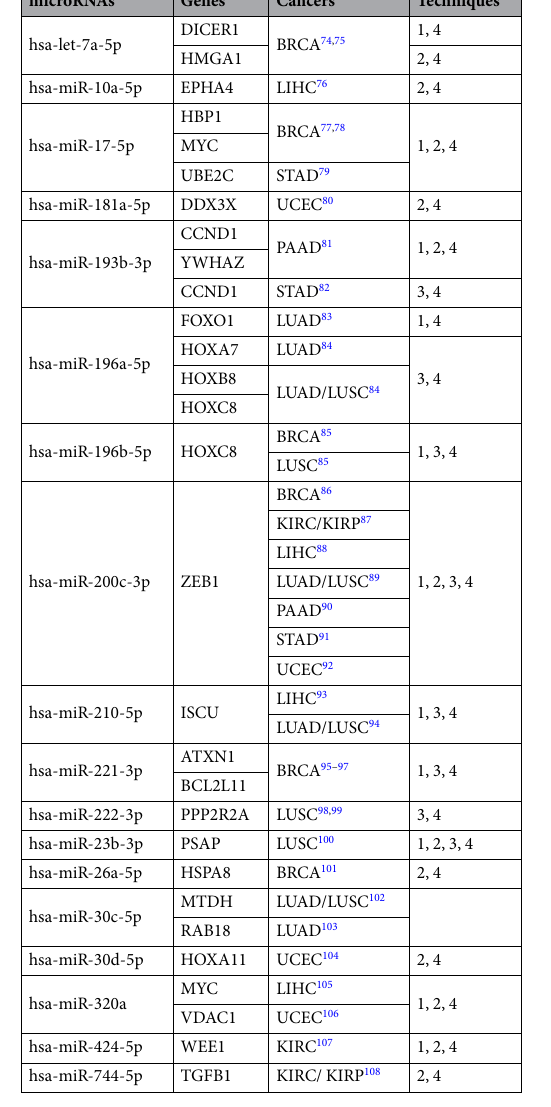
Table 4. Detailed information of validated interactions from literatures. Validation Techniques: (1) Luciferase reporter assay, (2) quantitative RT-PCR, (3) Western blot analysis, (4) miRNA